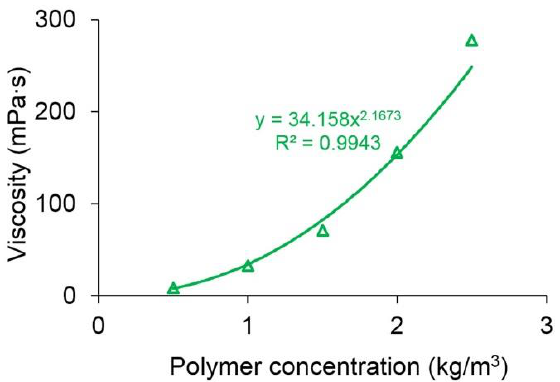
Figure 6. The relationship between the viscosity of the polymer solution and polymer concentration.